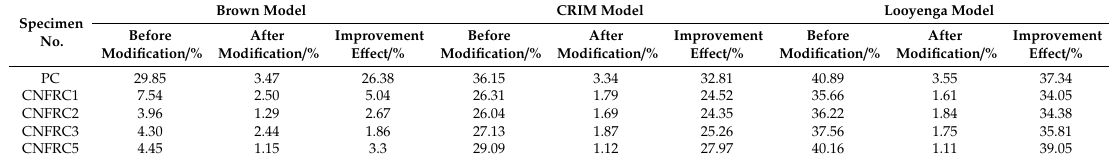
Table 6. Average errors for ε „ before and after improvement of models. Specimen